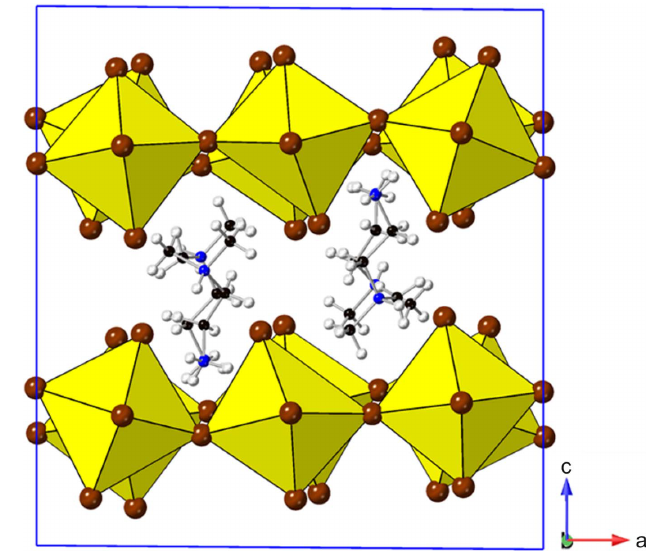
Figure 16 Unusual combination of in-phase and out-of-phase tilts/distortions observed in [C 4 H 14 N 2 ]PbBr 4